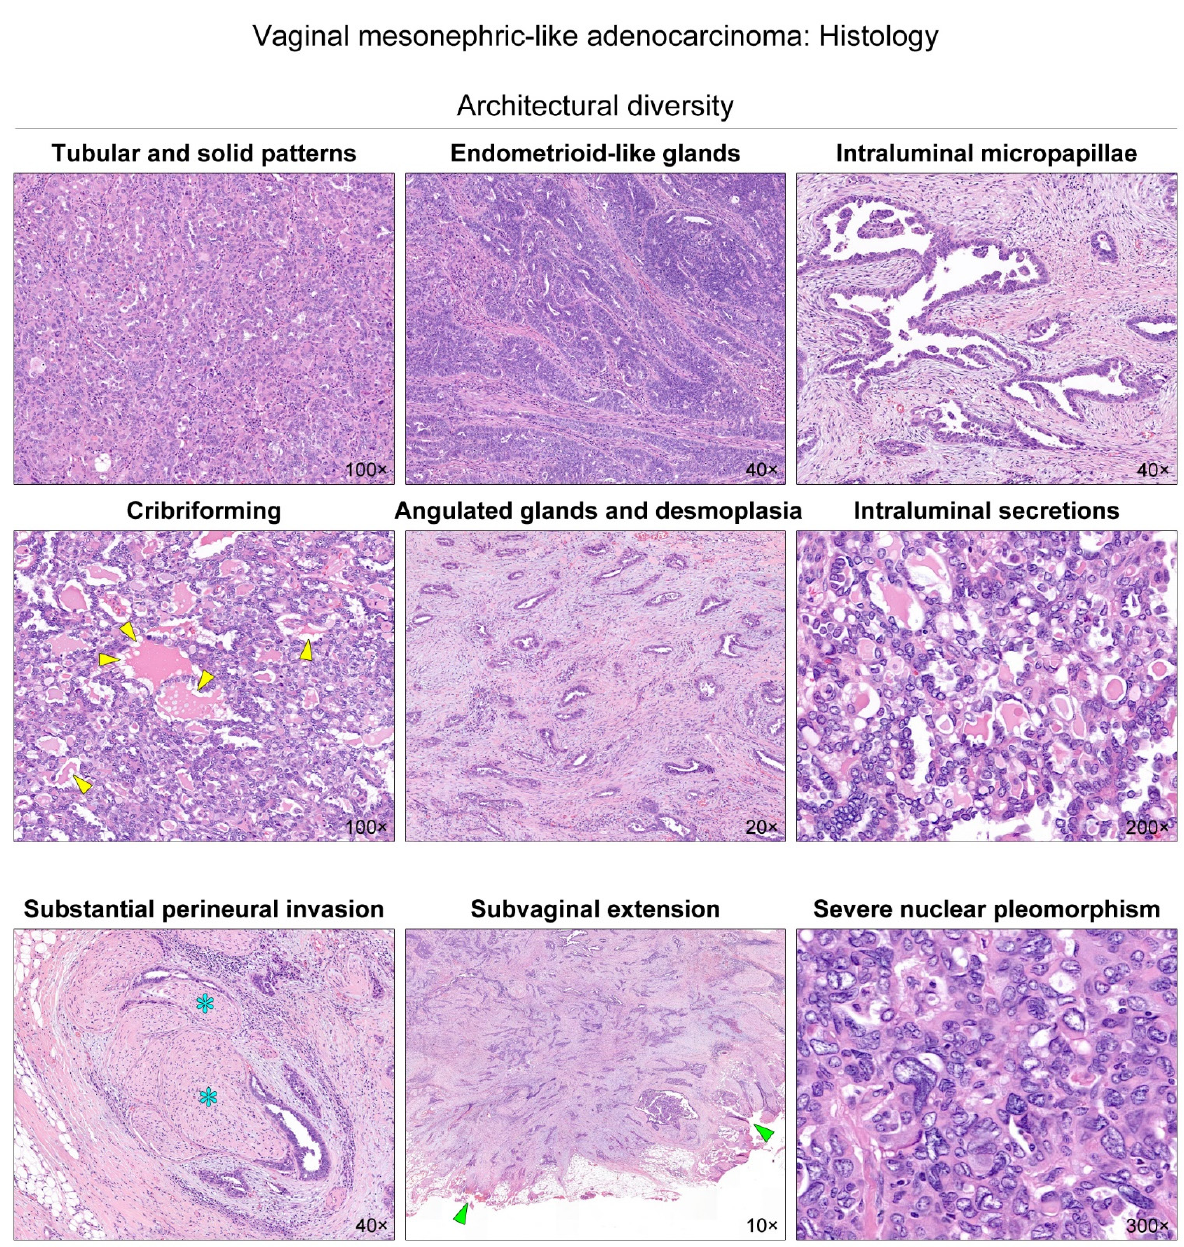
Figure 2. Histological features of vaginal mesonephric adenocarcinoma (MA). The tumor exhibited diverse growth patterns, including compact aggregation or fusion of small tubules, solid cellular sheets, endometrioid-like glands and ducts, papillary and micropapillary architecture, cribriform structure, and scattered, angulated glands associated with prominent desmoplastic stroma. The tubules and glands possessed hyaline-like, densely eosinophilic intraluminal secretions. These secretions had a sharp luminal contour or showed occasional vacuoles that resembled peripheral scalloping of colloid observed in thyroid follicles (yellow arrowheads). We also noted some histological features suggesting aggressive behavior. The variable-sized neoplastic glands grew around and within the nerve fibers (blue asterisks). The infiltrating tumor tissue involved the subvaginal soft tissue resection margin (green arrowheads). In addition, areas showing severe nuclear pleomorphism, enlargement, and marked irregularity of nuclear membrane were frequently observed. Since MA typically displays relatively small, uniform nuclei with minimal-to-mild pleomorphism, our observation of high-grade nuclear atypia seems unusual for vaginal